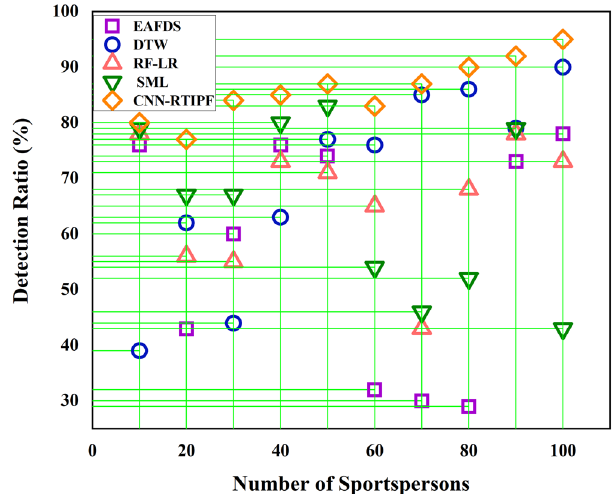
Figure 8: Detection ratio.